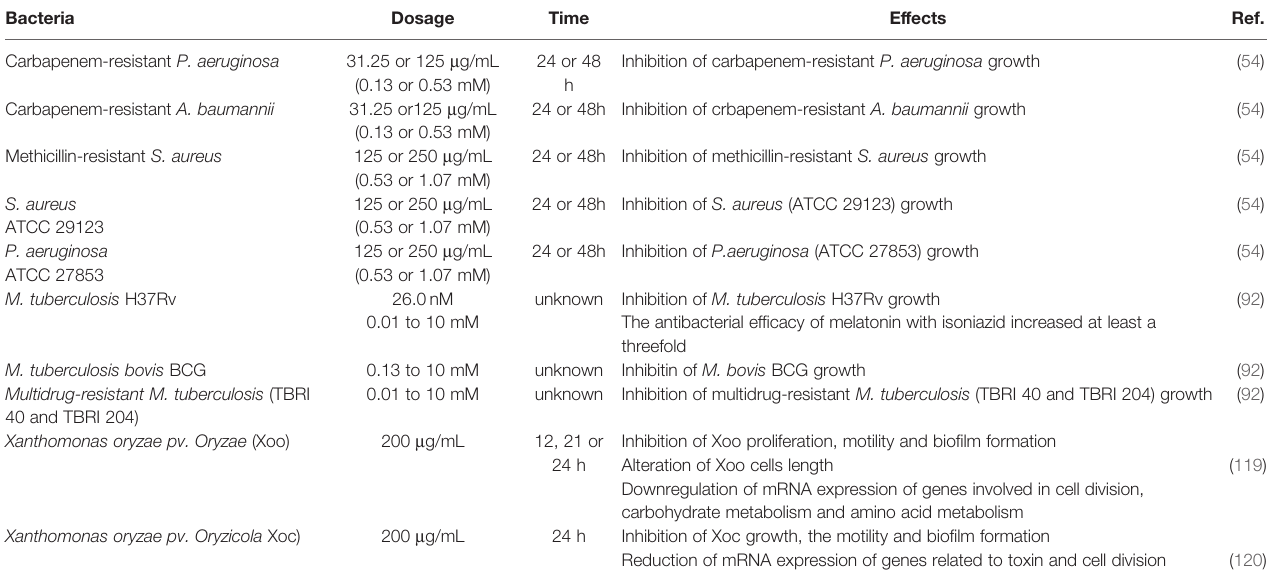
TABLE 1 | The antibacterial action of melatonin in vitro on different bacteria. Bacteria Dosage Time Effects